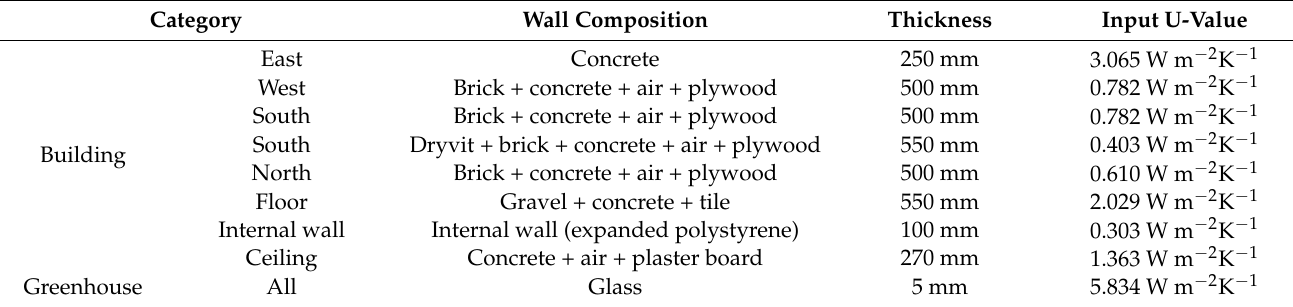
Figure 5. The three-dimensional BES model designed for analysing building energy load: ( a ) 3D front view of the experimental office building, ( b ) 3D rear view, and ( c ) building-integrated rooftop greenhouse (BiRTG). Table 2. Design of wall layers of the office BES